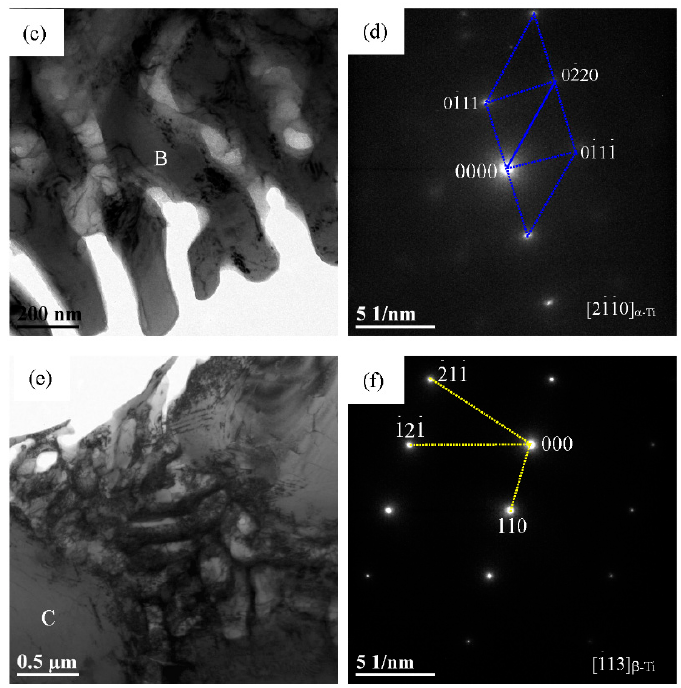
Figure 4. Transmission electron microscope (TEM) bright field images ( a ), ( c ), and ( e ) of Ti 75 Fe 19 Sn 5 Mo 1 alloys. ( b ), ( d ), and ( f ) Electron diffraction patterns taken respectively from the areas marked “A”, “B”, and “C” in ( a ), ( c ), and ( e ).